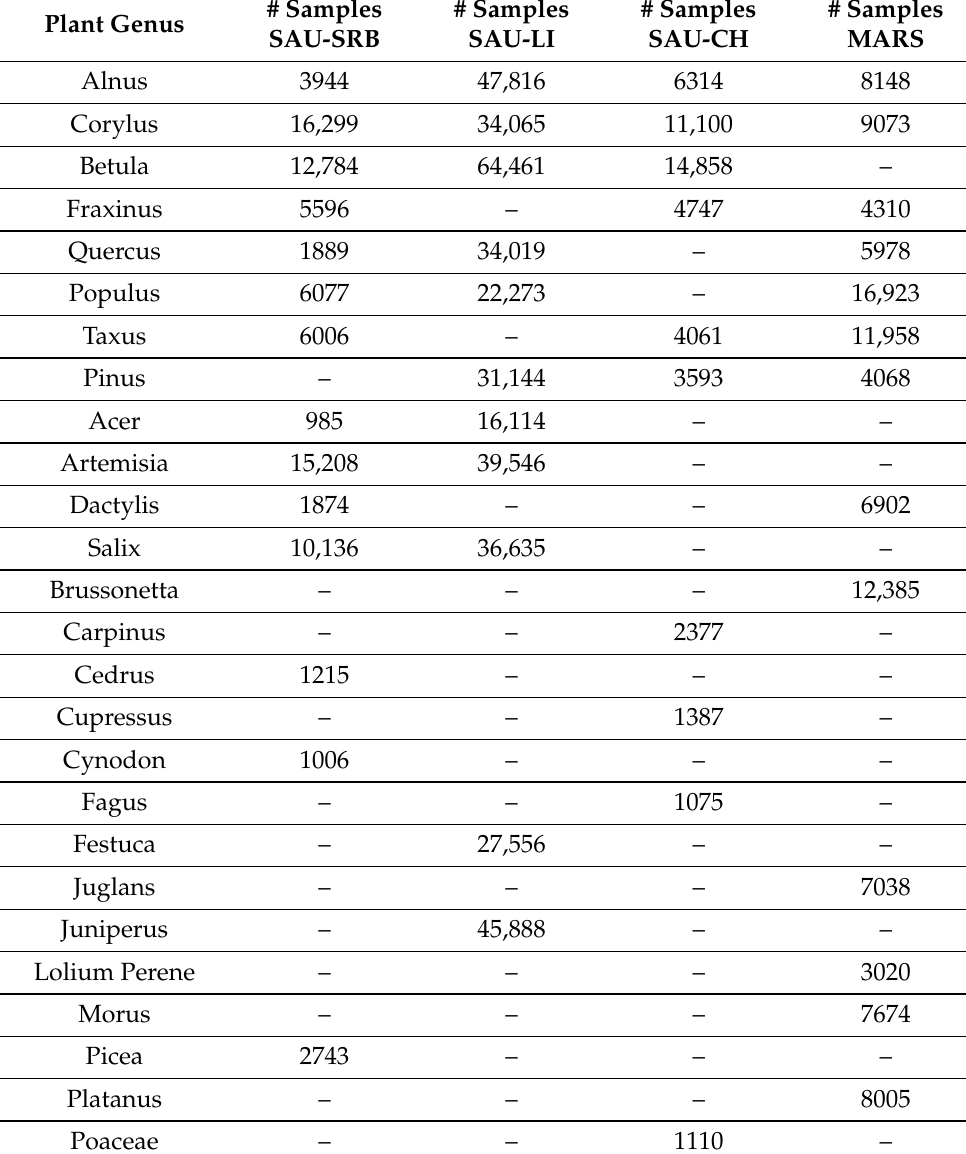
Table 2. Datasets